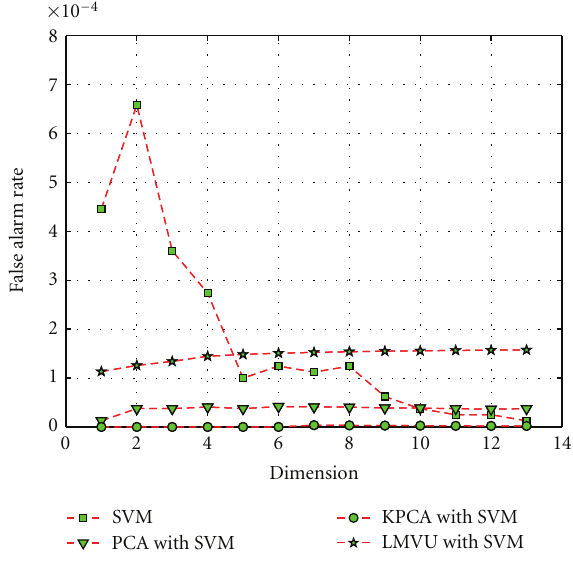
Figure 6: False alarm rate.